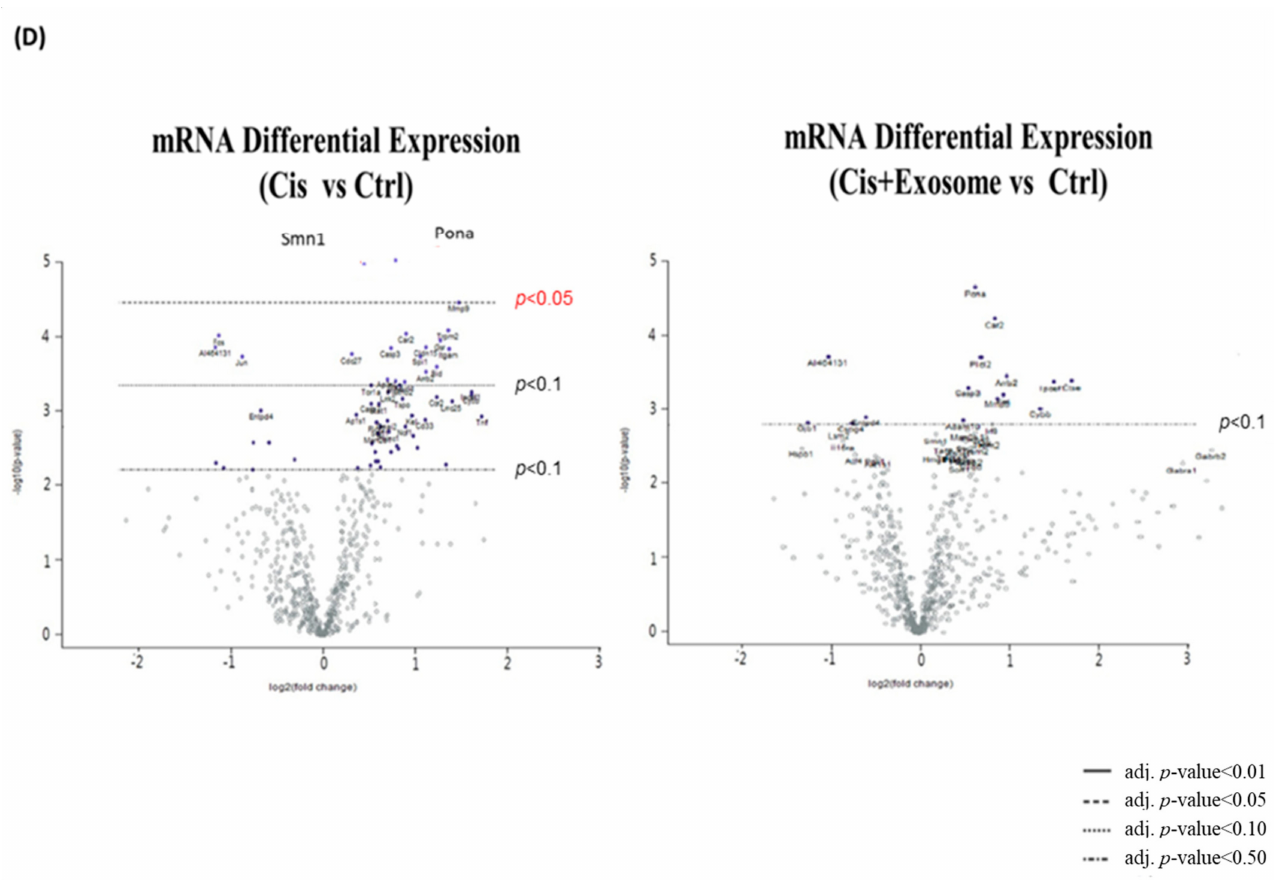
Figure 6. Neuropathological gene panel analyses of the biological pathways of umbilical cord mesenchymal stromal cell (UCMSC) exosomes in mice with cisplatin-induced hearing loss. ( A ) Increases in the gene scores of biological pathways in the mRNA expression profiles of the cochlear tissues were observed in three to five representative mice receiving chronic cisplatin injection. Ctrl = orange, Cis = gray, and Cis + Exosomes = blue. ( B ) Decreases in the gene scores involved the biological pathways in the mRNA expression profiles of the cochlear tissues in the representative mice receiving chronic cisplatin injection. Ctrl = orange, Cis = gray, and Cis + Exosomes = blue. ( C ) After normalization with the control group, the heatmap of gene expression profiles in each biological pathway of cisplatin vs. control (ctrl) and UCMSC exosomes (cisplatin mice treated with 1.2 mg/mL UCMSC exosomes) vs. control. The color codes represent the scores after normalization: positive scores are coded in brown or orange, and negative scores are coded in dark or light blue. ( D ) Volcano analyses indicated the differentially increased and decreased genes after normalization with ctrl mice. (i) SMN1 and Pona were significantly increased in the cisplatin group compared with in the control group. (ii) After UCMSC-exosome treatment, SMN1 was totally inhibited, and Pona was significantly reduced, since Pona was not significantly elevated (only above the line of adjusted p -value < 0.5 and does not reach the line of adjusted p -value < 0.1 and adjusted p -value < 0.05) in the cochlear tissues of cisplatin-injected mice. Statistical significance was defined as p < 0.05 in red